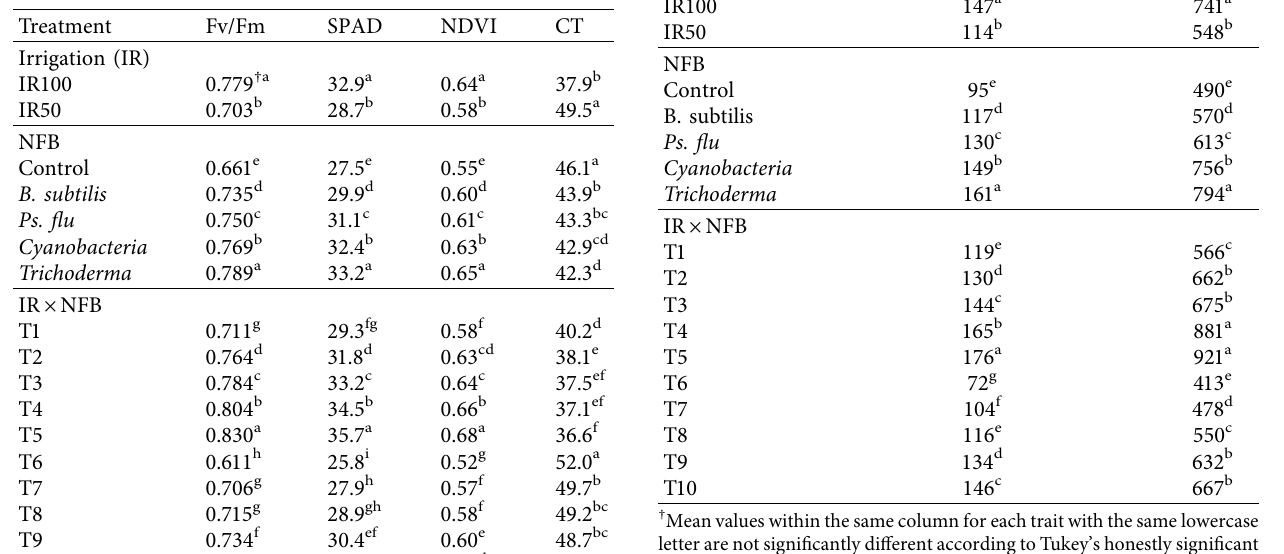
Table 4: Effects of nitrogen-fixing bacteria (NFB) on the quantum efficiency of photosystem II (PSII) in dark- and light-adapted conditions (Fv/Fm), chlorophyll content (SPAD-value), plant’s health (normalized difference vegetation index, NDVI), and can- opy temperature (CT) expressed in Celsius degrees ( ° C), of clary ( Salvia sclarea ) plants grown under two irrigation (IR) treatments.